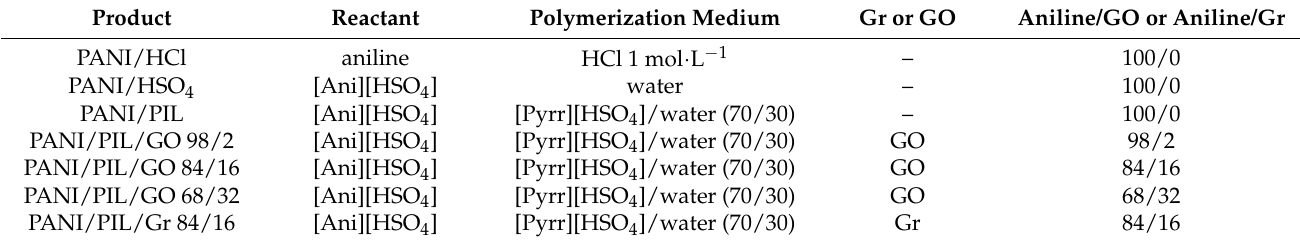
Table 1. Reactant, polymerization medium, and aniline/GO mass ratio of different investigated